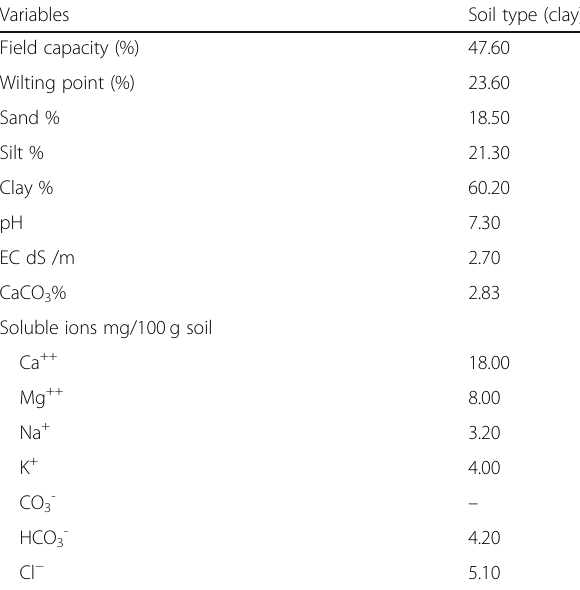
Table 1 Physical and chemical analyses of the experimental soil Variables Soil type (clay) Field capacity (%)